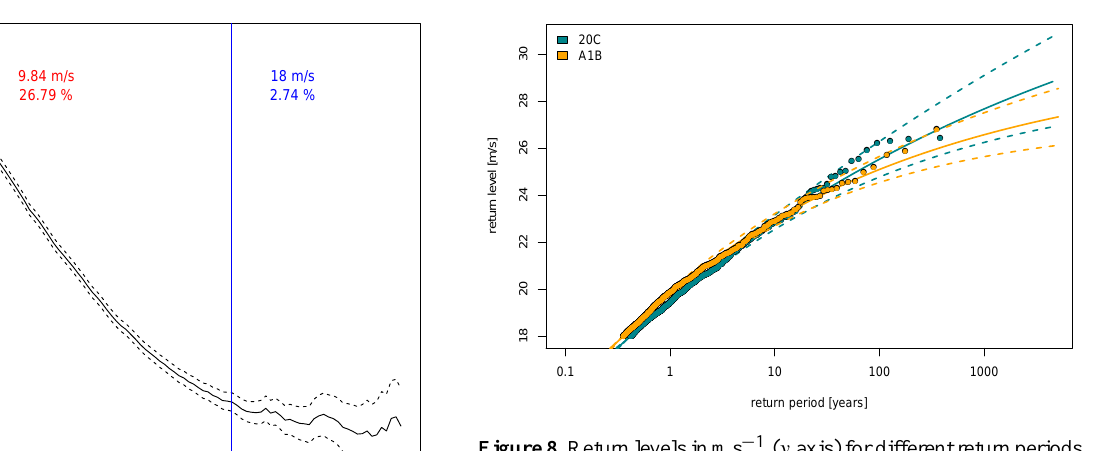
Figure 8. Return levels in ms − 1 ( y axis) for different return periods in years ( x axis) for 20C (1901–2000, turquoise) and A1B (2001– 2100, orange) + the 95% confidence intervals (dashed lines). Only effective wind component values exceeding 18ms − 1 are consid-